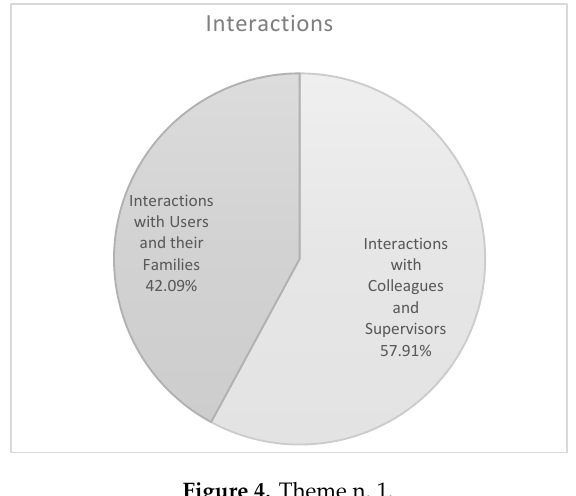
Figure 4. Theme n. 1. Table 2. Risk and protective factors of well-being at work: data comparison between educators and nurses.